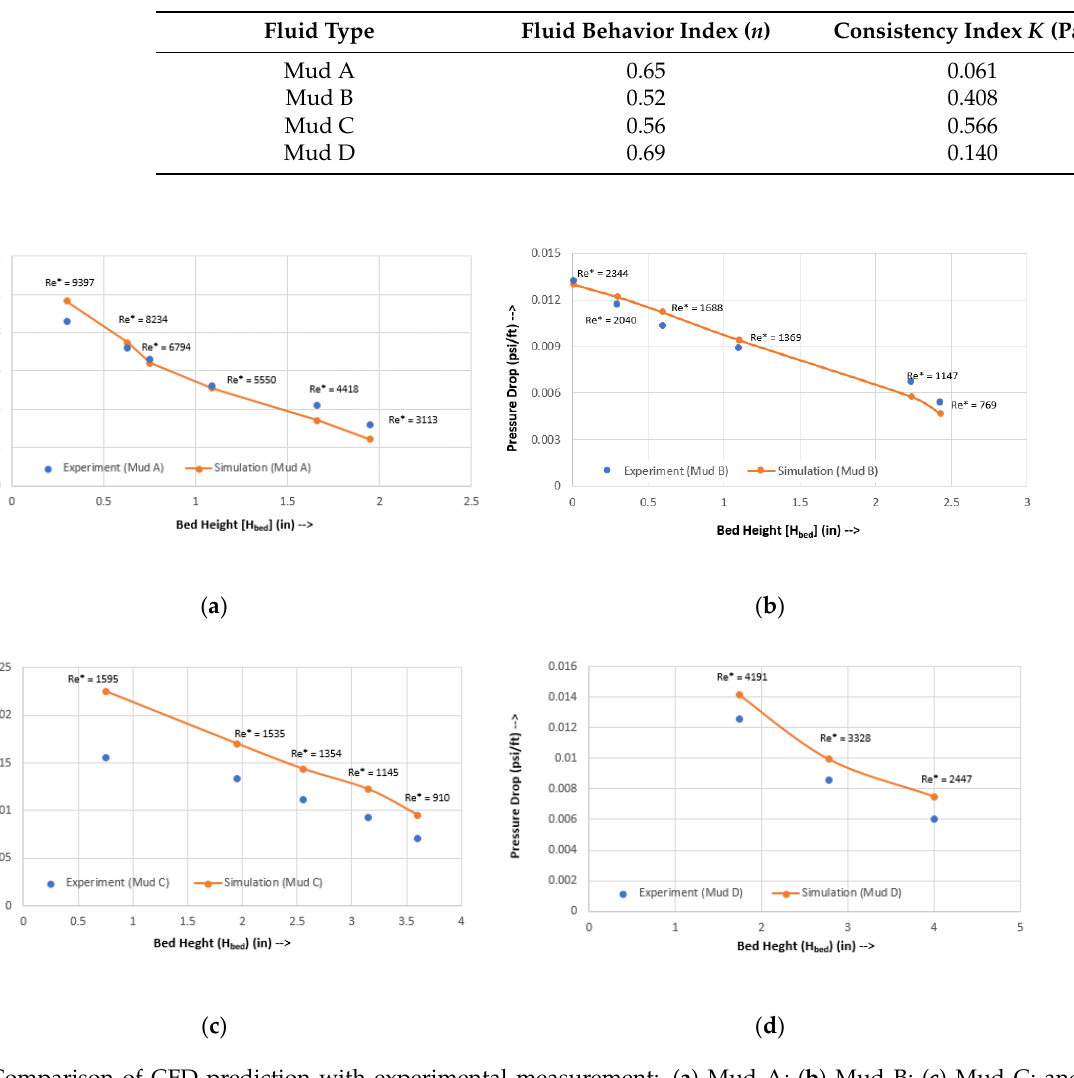
Figure 4. Comparison of CFD prediction with experimental measurement: ( a ) Mud A; ( b ) Mud B; ( c ) Mud C; and ( d ) Mud D.